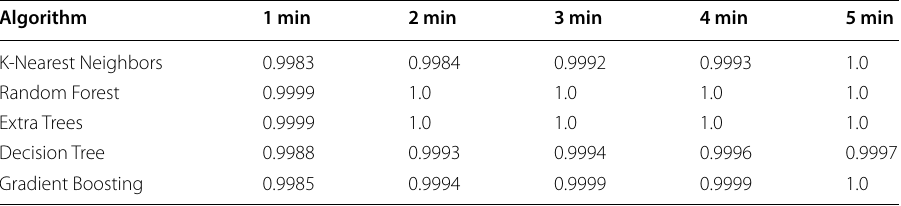
Table 4 Algorithm accuracy for different algorithms and different training times using the HCILAB